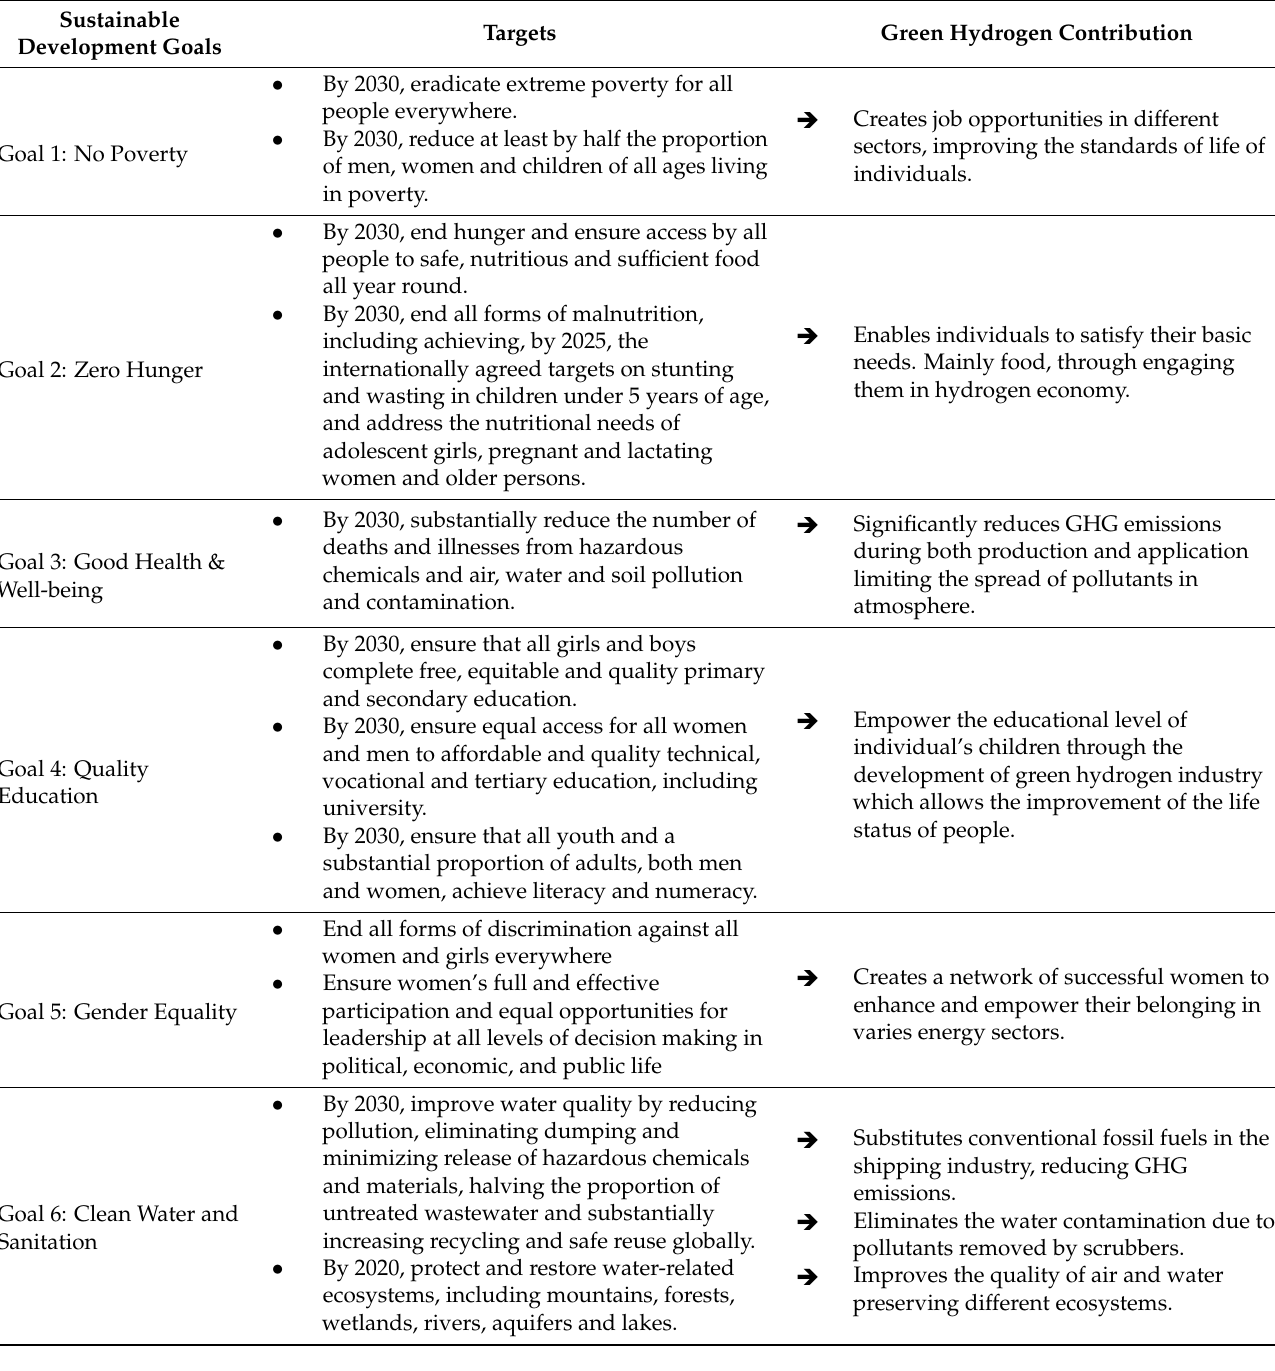
Table 1. Contribution of Green Hydrogen to Sustainable Development